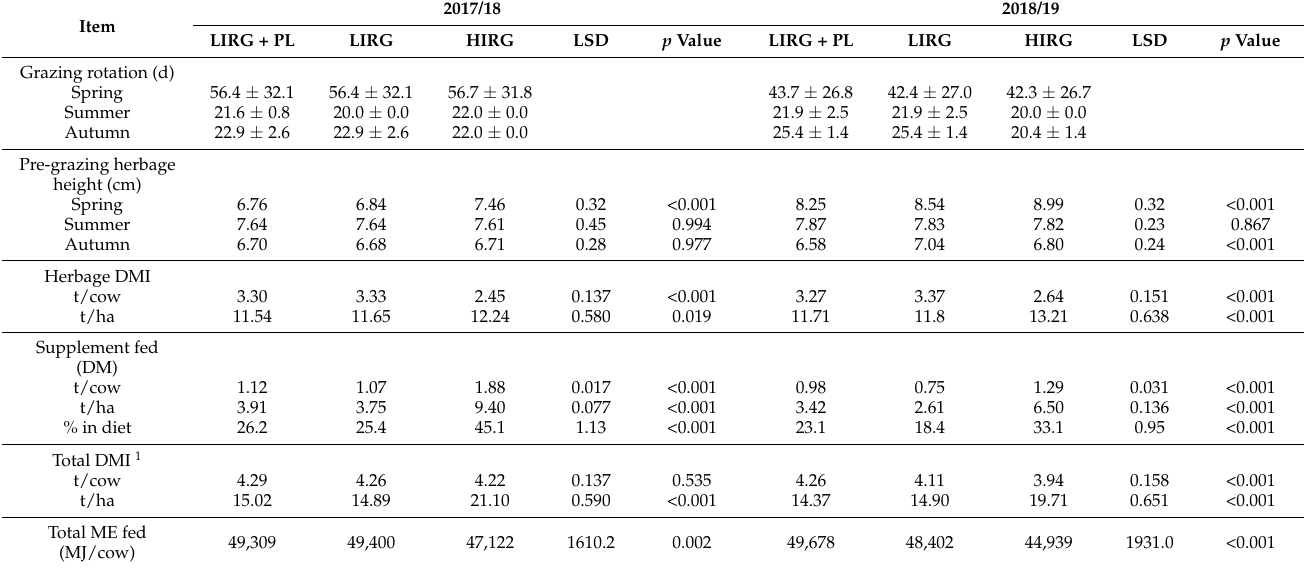
Table 3. Grazing rotation intervals (mean ± SD), compressed pre-grazing herbage height, herbage dry matter intake (DMI), supplement dry matter (DM) fed and % in diet, total DMI, and total metabolisable energy (ME) fed to dairy cows grazing ryegrass and plantain-based swards in a lower input system (LIRG + PL; 3.5 cow/ha stocking rate and herbage received 150 kg nitrogen/ha/year), perennial ryegrass–white clover mix sward in a lower input system (LIRG; 3.5 cow/ha and herbage received 150 kg nitrogen/ha/year), or perennial ryegrass–white clover mix sward in a higher input system (HIRG; 5 cow/ha and herbage received 300 kg nitrogen/ha/year) during the lactation period (from August to May) in 2017/18 and 2018/19 milking